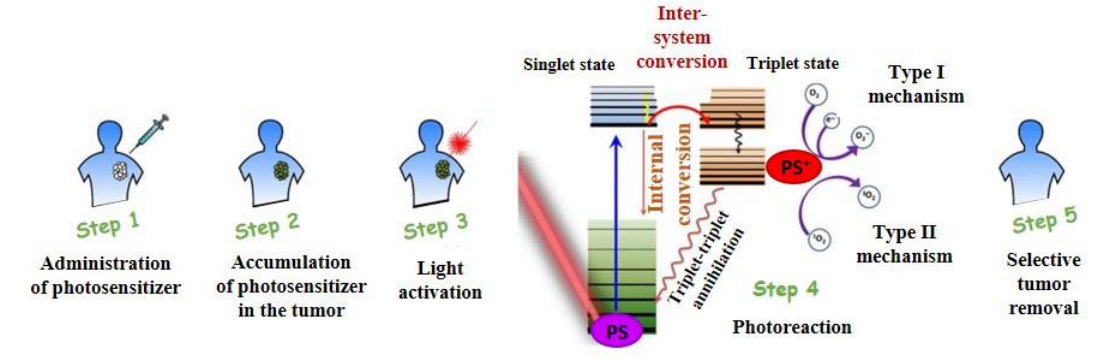
Figure 1. Scheme of photodynamic therapy (PDT; edited by [42,43]).